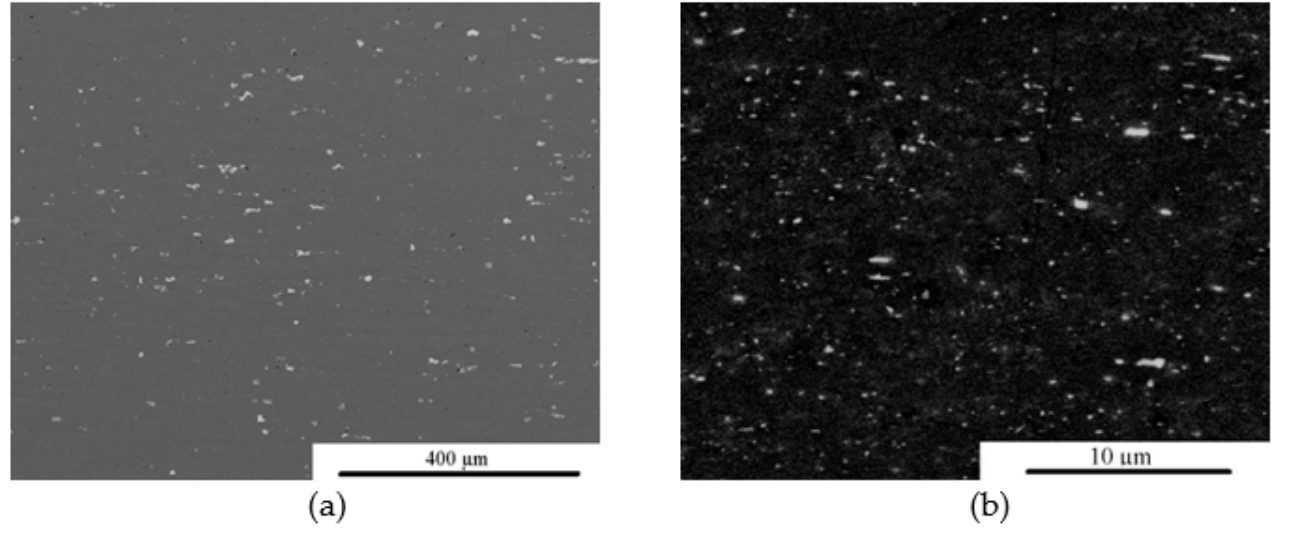
Figure 5. Second phase particles in the AlMg 6 Mn 0.7 (1565 ch) alloy after hot deformation in the reversing stand: ( a ) intermetallic compounds; ( b ) dispersoids. Table 4. Dimensions and volume fraction of intermetallic compounds in the AlMg 6 Mn 0.7 (1565 ch)